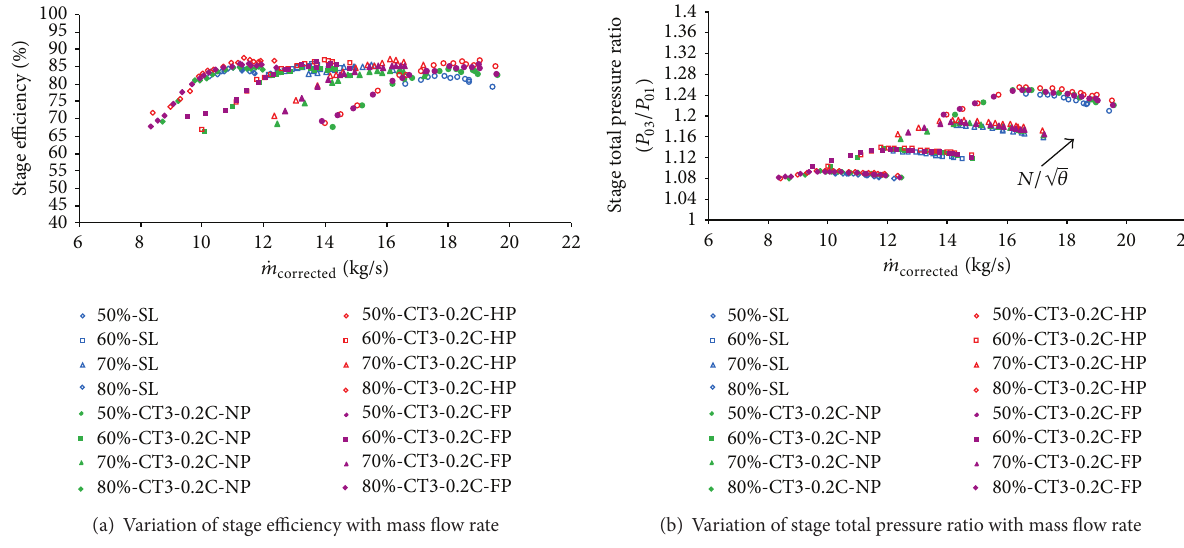
Figure 4: Compressor operating envelop with solid casing and casing treatment at 20% axial